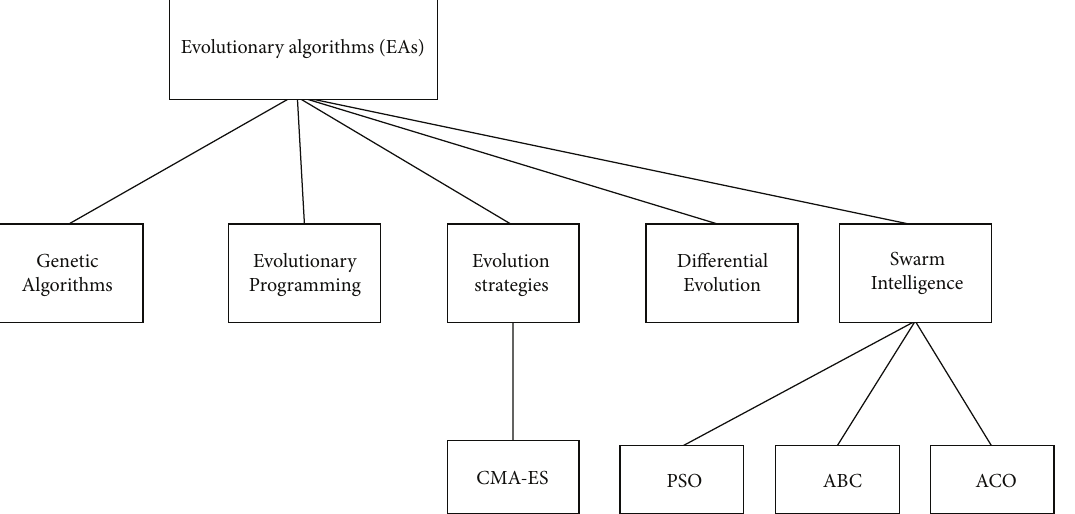
Figure 1: A diagram depicting main families of evolutionary